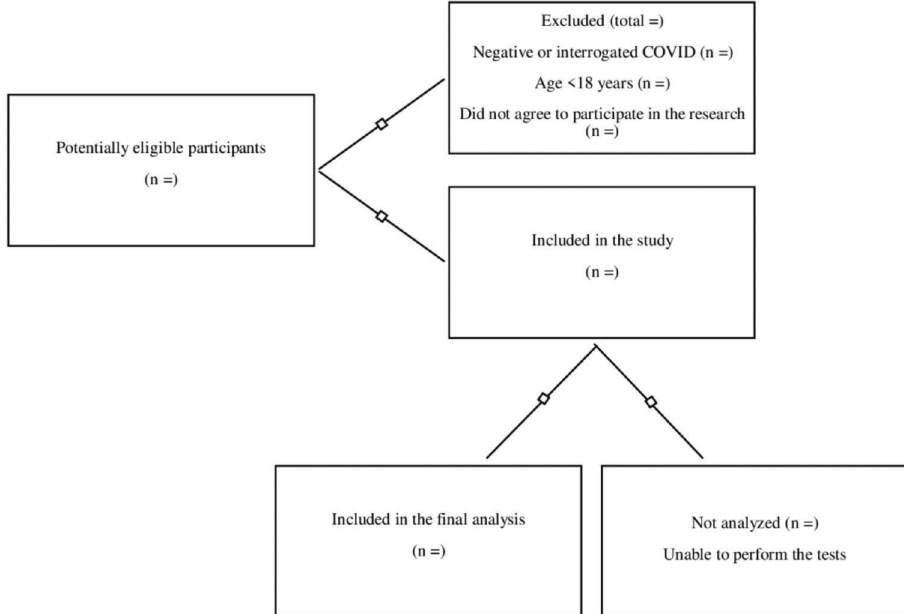
Figure 1 - Flowchart of the participant selection process.